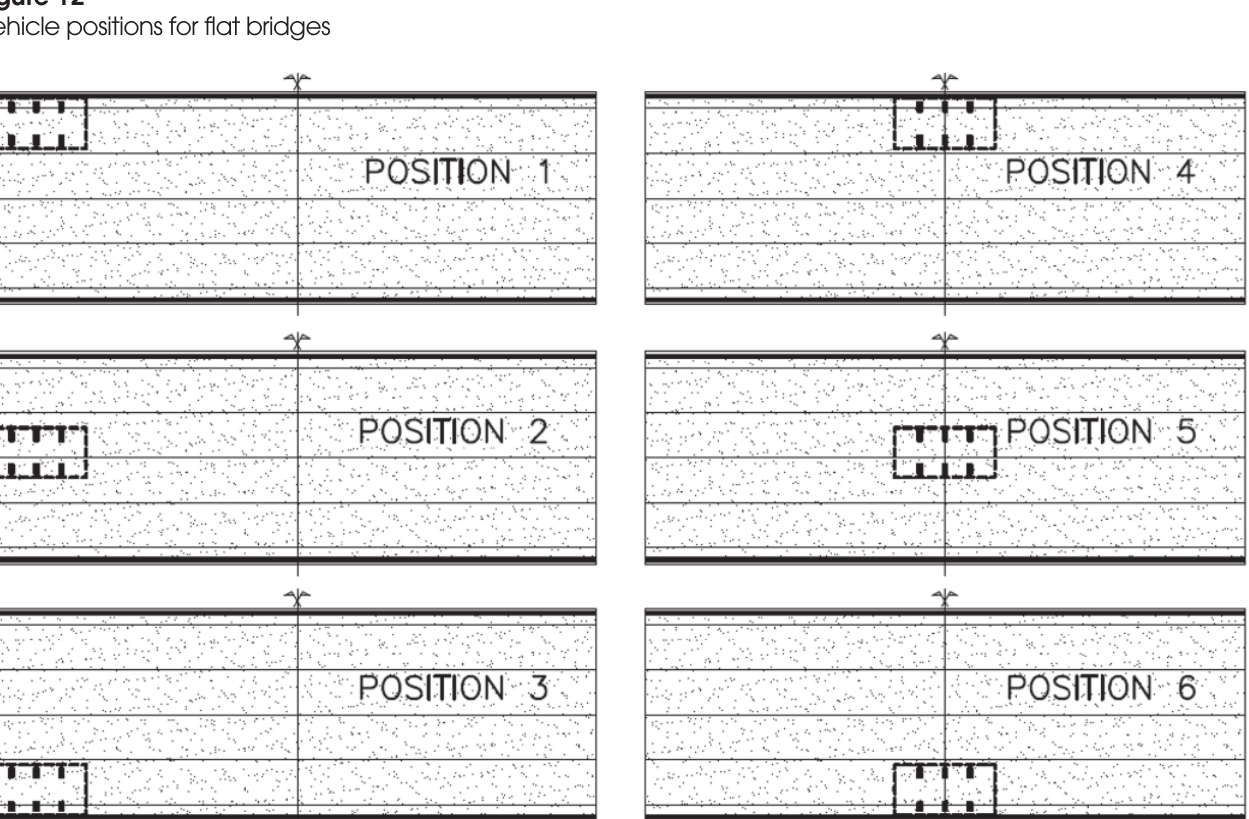
Vehicle positions for multi-girder